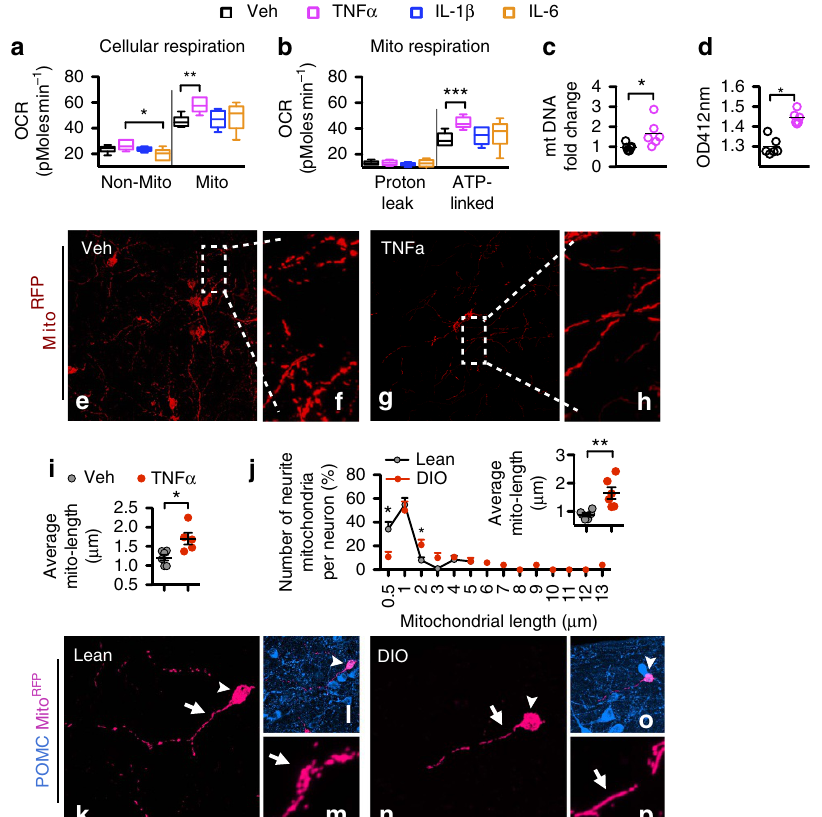
Figure 2 | TNF a stimulates mitochondrial ATP production and mitochondrial elongation in neurites of hypothalamic neurons. ( a , b ) Neurons treated with TNF a had a significantly increased ATP-linked mitochondrial OCR in comparison to those treated with vehicle, IL-1 b or IL-6 ( n ¼ 6 wells for each treatment, F (1,20) ¼ 4.39, P ¼ 0.016 for Mito-OCR, t 10 ¼ 4.294, P ¼ 0.002 for TNF a versus vehicle; F (1,20) ¼ 3.62, P ¼ 0.031 for ATP-linked OCR, t 10 ¼ 2.921, P ¼ 0.015 for TNF a versus vehicle); in addition, there was a significant difference in non-mito OCR, F (1,20) ¼ 4.39, P ¼ 0.016, contributed by the difference between TNF a versus IL-6, t 10 ¼ 2.921, P ¼ 0.015). ( c ) Mitochondrial copy number was significantly increased in TNF a -treated neurons ( n ¼ 7 for vehicle and n ¼ 6 for TNF a , P ¼ 0.018). ( d ) Mitochondrial citrate synthase activity was unregulated in TNF a -treated neurons ( n ¼ 6, P o 0.001). ( e – i ) Mitochondrial length in TNF a -treated mice in the MBH was significantly longer than in vehicle-injected mice ( n ¼ 6 for vehicle and n ¼ 5 for TNF a , P ¼ 0.014). ( j – p ) Mitochondria in the neurites of POMC neurons (arrowheads in k – p ) were elongated in DIO mice ( n ¼ 6 mice) in comparison to those in lean mice ( n ¼ 6 mice; for each length: P ¼ 0.011 for 0.5 m m; P ¼ 0.025 for 2 m m; P ¼ 0.058 for 3 m m; POMC neurons in lean mice did not contain mitochondria longer than 6 m m; for average mito-length, P ¼ 0.005), higher magnification of Mito RFP -labelled mitochondria (arrows) are presented in l , o . Scale bars, 100 m m in e , g , 12 m m in f , h ; 30 m m in k , n ; 60 m m in l , o ; 8.5 m m in m , p . * P o 0.05, ** P o 0.01, *** P o 0.001. Data are presented as min to max in a , b , and means ± s.e.m. in c , d , i , j . P values were analysed by one-way ANOVA followed by post hoc t -test in a , b , and by two-tailed Student’s t -test in c , d , i , j